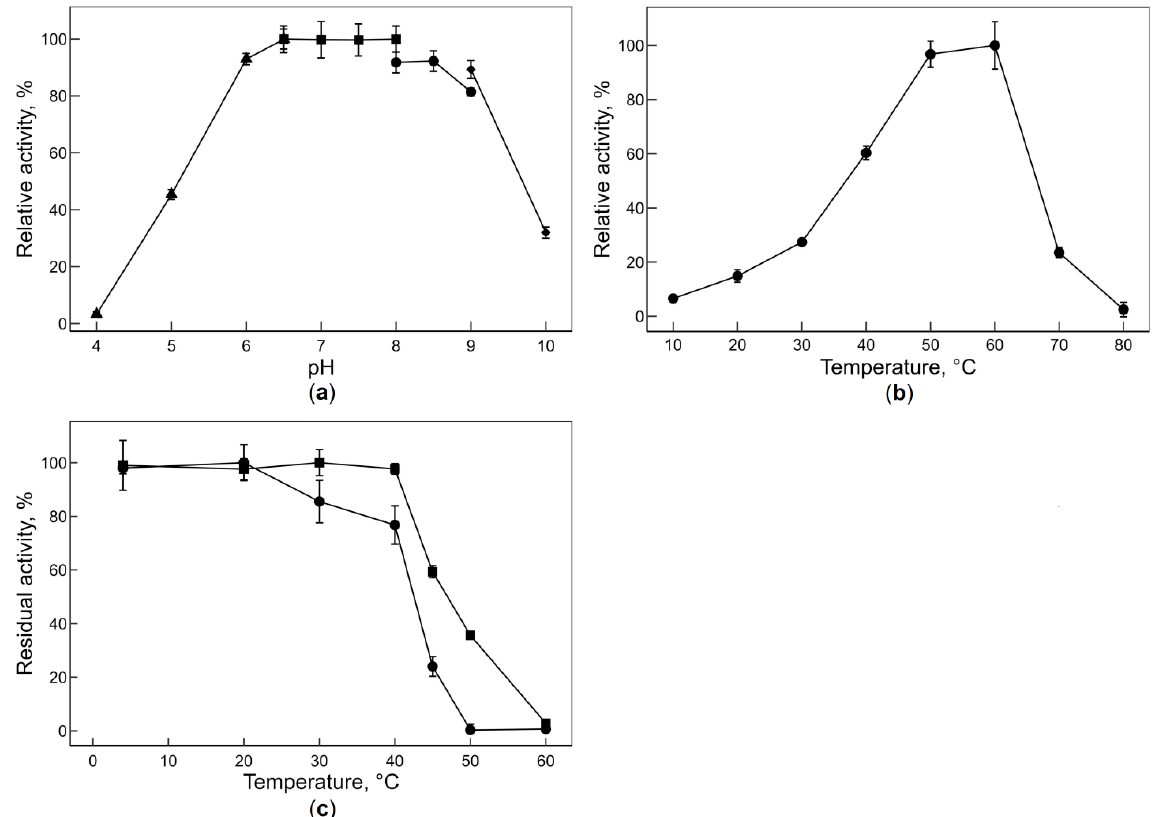
Figure 3. Effect of pH and temperature on the activity of PsLam81A enzyme. ( a ) Effect of pH on enzyme activity in sodium citrate buffer (triangles), sodium phosphate buffer (squares), Tris-HCl buffer (circles), glycine-NaOH buffer (diamonds). ( b ) Effect of temperature on enzyme activity. ( c ) Effect of temperature on enzyme stability after incubation at indicated temperatures for 15 min (squares), 60 min (circles). The bars represent SD.